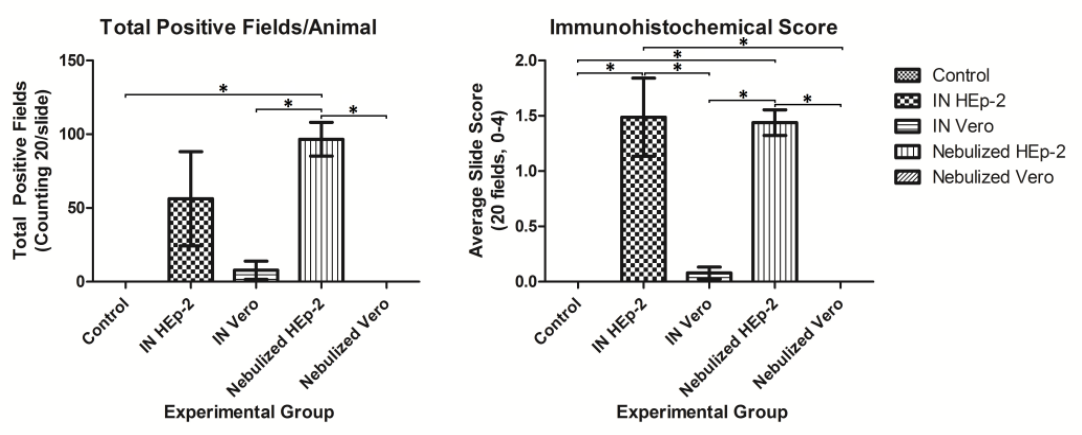
Figure 6. RSV immunohistochemical stain scoring. Seven slides with two sections each of lung lobe (at least 1 cm × 1 cm) were scored for staining of RSV antigen. Slides were assessed for number of cells per 10X field with RSV antigen staining which was then given a score according to the following scale: 0 = 0, 1 = 1–10, 2 = 11–39, 3 = 40–99, 4 =>100; slides were also assessed for the number of 10X fields with RSV antigen out of 20 fields for each slide. Both groups inoculated with HEp-2-grown RSV had higher average slide scores than control or either group inoculated with Vero-grown RSV. Nebulized HEp-2-grown RSV had significantly more fields with RSV antigen than control or Vero-grown RSV groups, p <